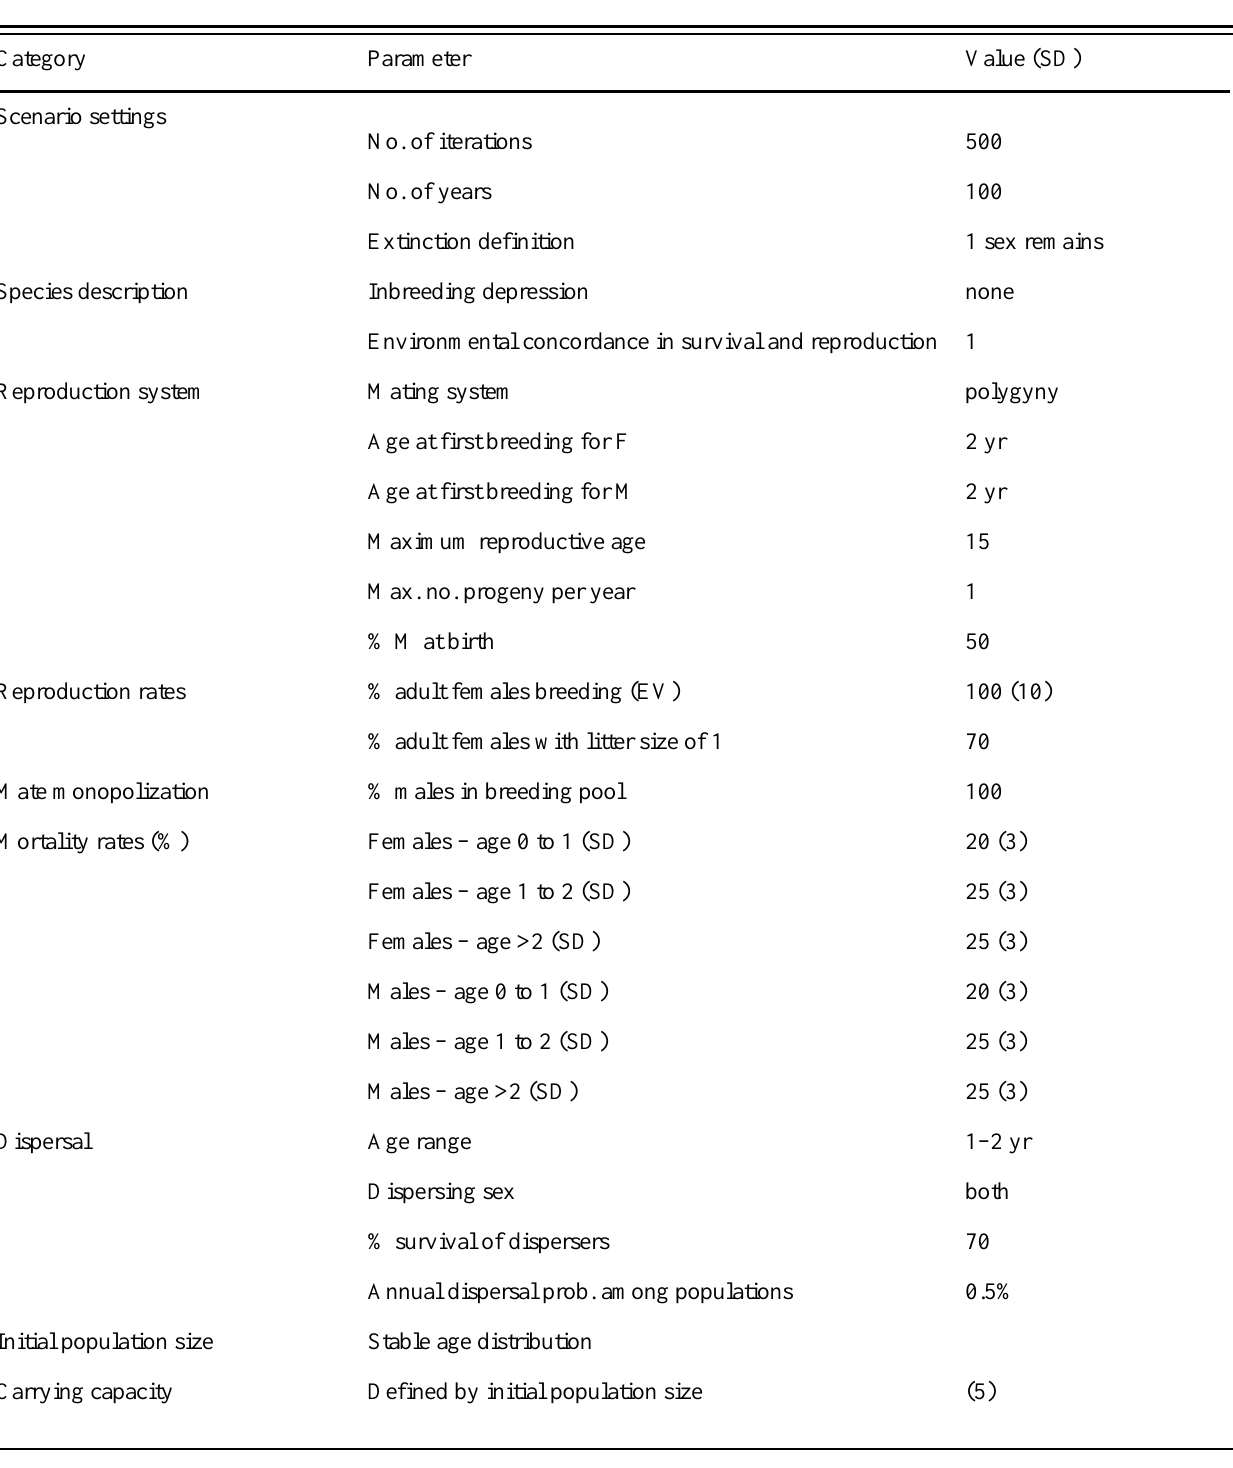
Table 1. Parameters and values used in the PVA for the basic